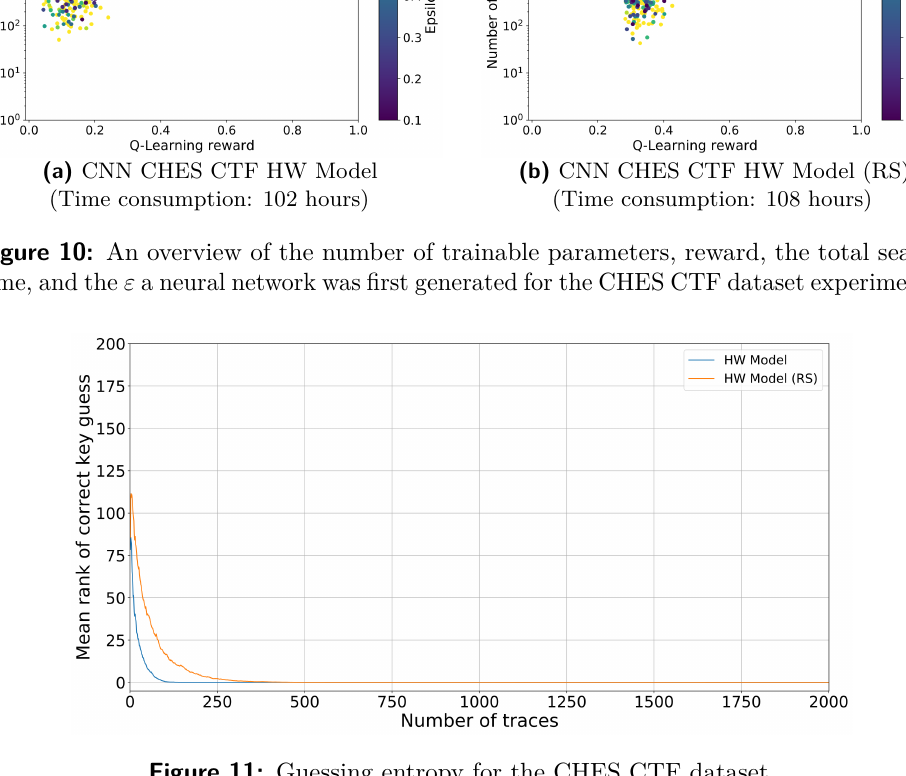
Figure 11: Guessing entropy for the CHES CTF